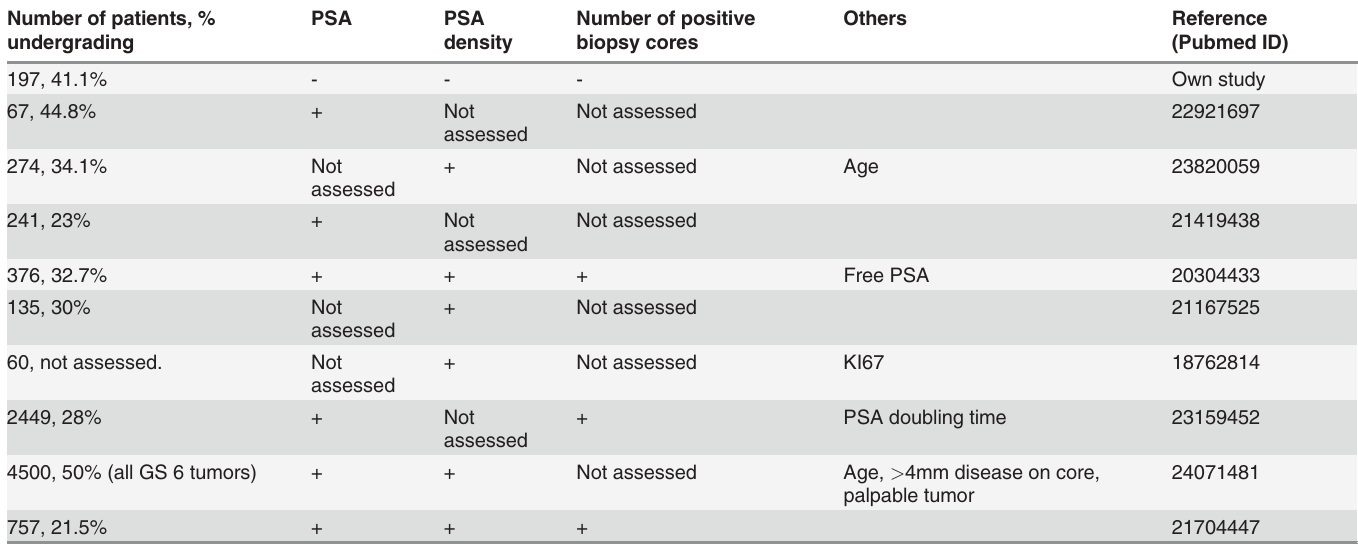
Table 1. Overview about clinical studies on biomarkers predicting undergrading; + positive association, — negative association. Number of patients, % undergrading